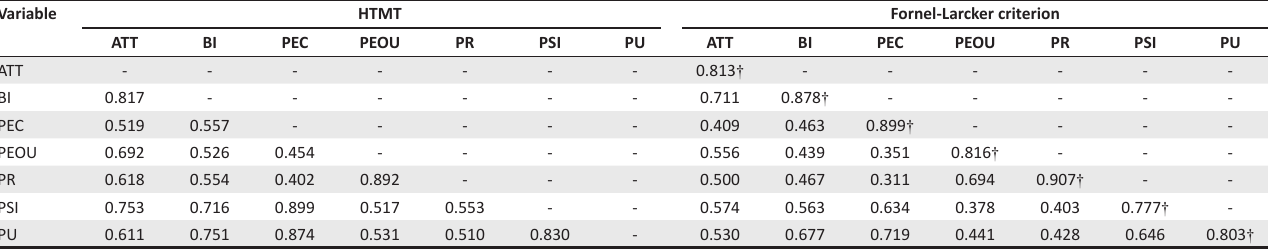
TABLE 2: Heterotrait-Monotrait and Fornel-Larcker criterion. Variable HTMT Fornel-Larcker criterion